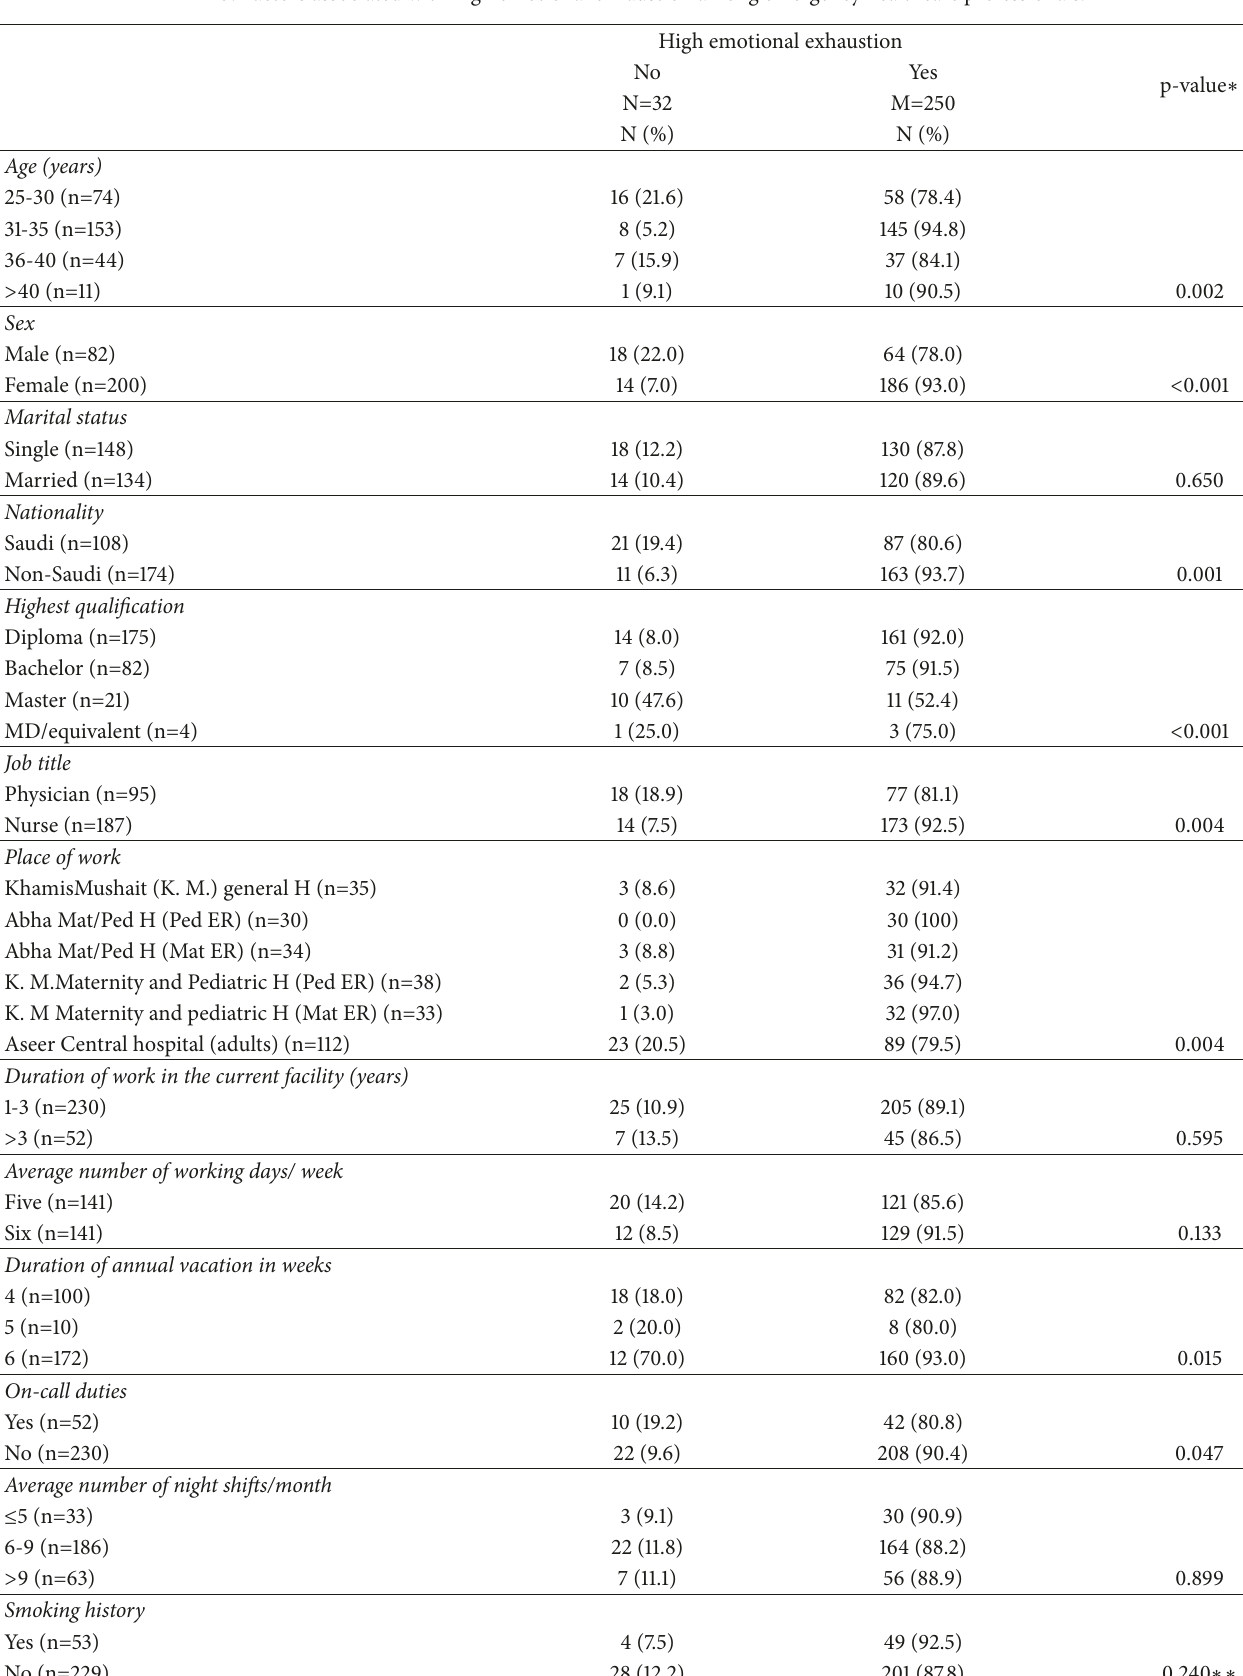
Table 3: Factors associated with high emotional exhaustion among emergency healthcare